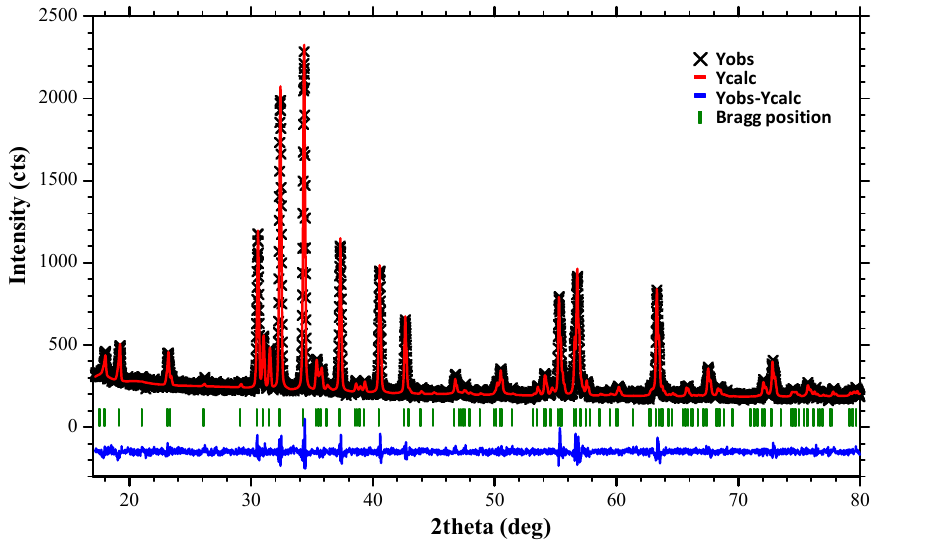
Figure 3. Rietveld analysis of BaFe 11.2 Mg 0.4 Al 0.4 O 19 . Table 2. Fitting results of BHF and Mg-Al doped BHF.